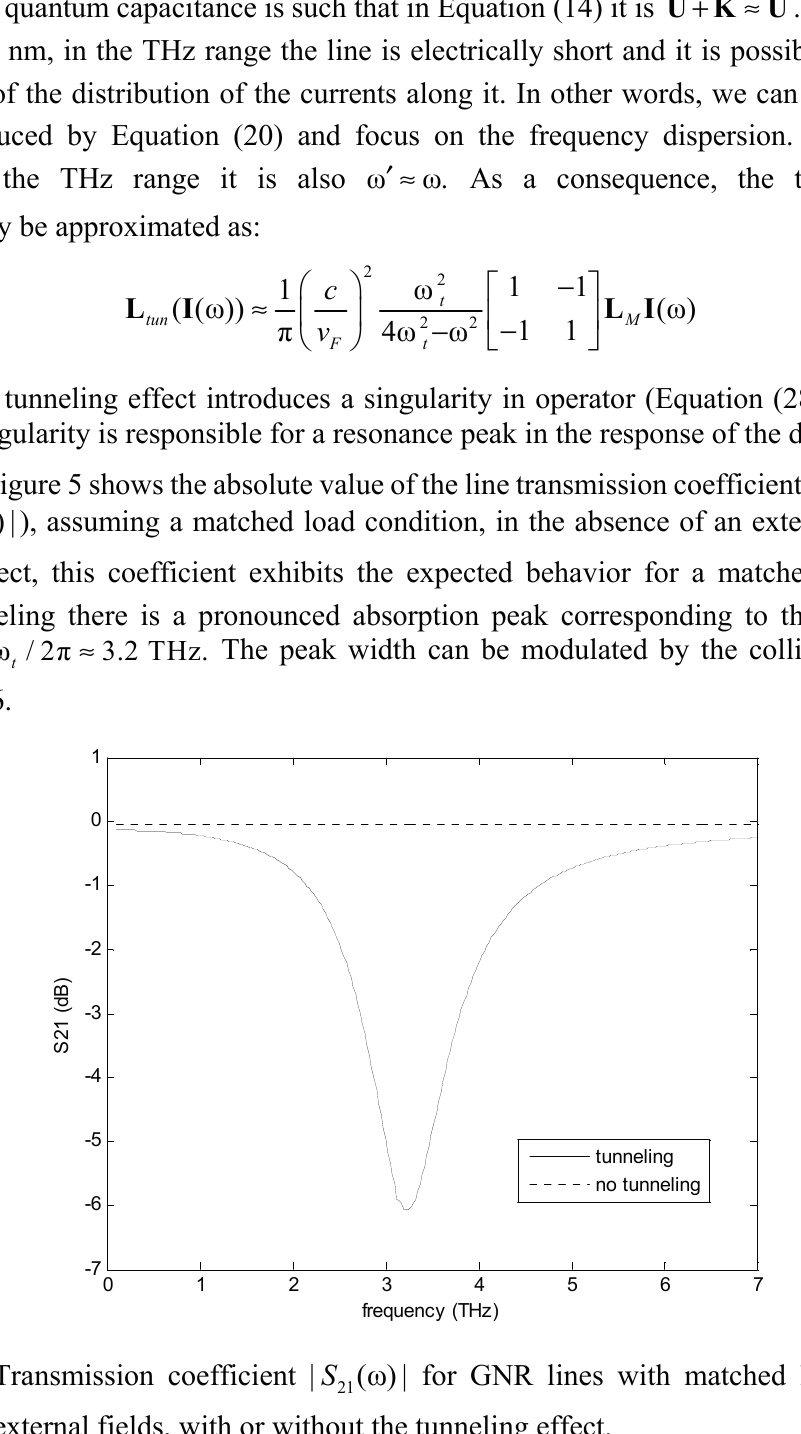
Figure 5. Transmission coefficient absence of external fields, with or without the tunneling effect.